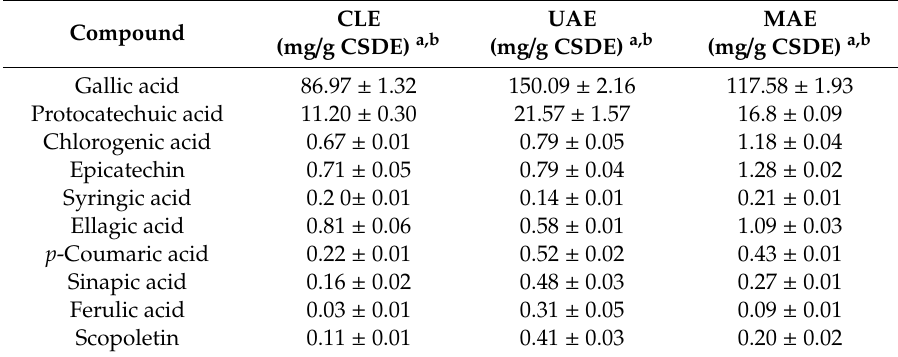
Table 2. Phenolic compounds identified by RP-HPLC in dry extracts from chestnut